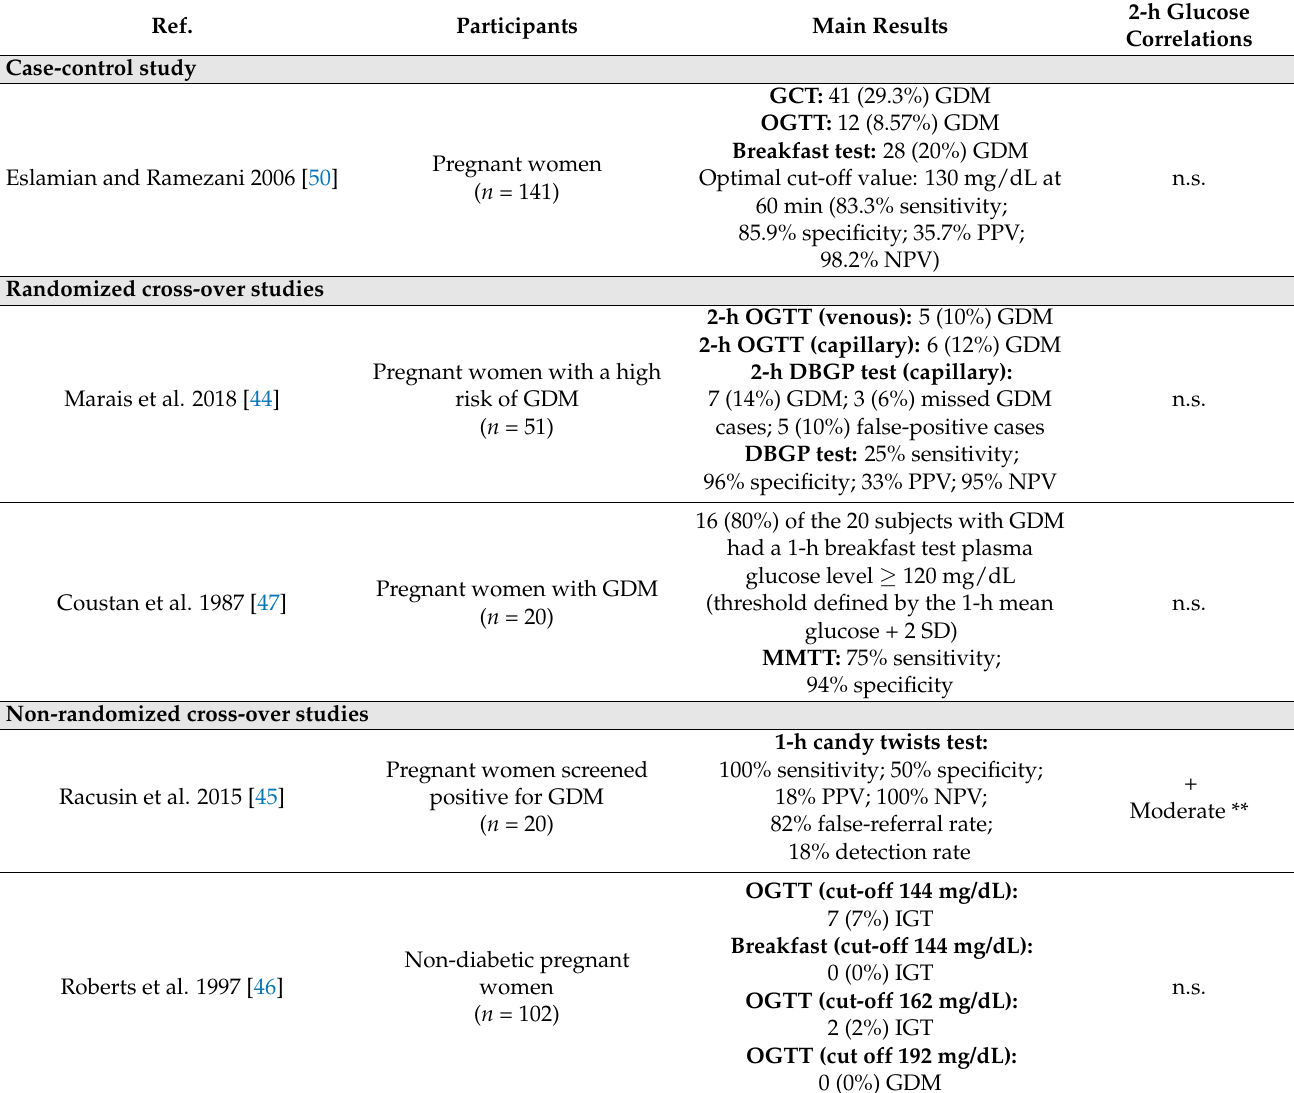
Table 3. Main characteristics and results of the selected studies that used the meal tests to screen gestational diabetes